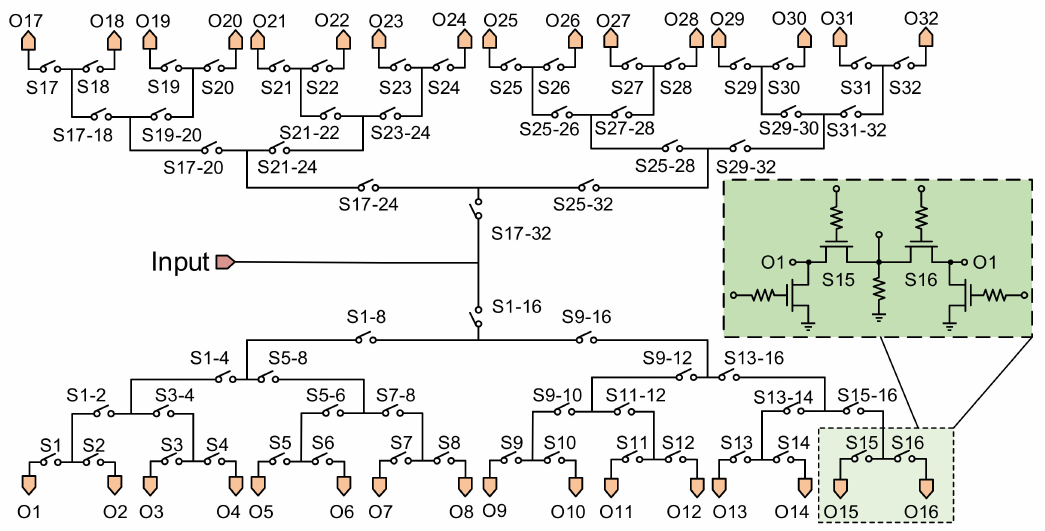
Figure 5. The proposed tree structure for the SP32T with high isolation between different